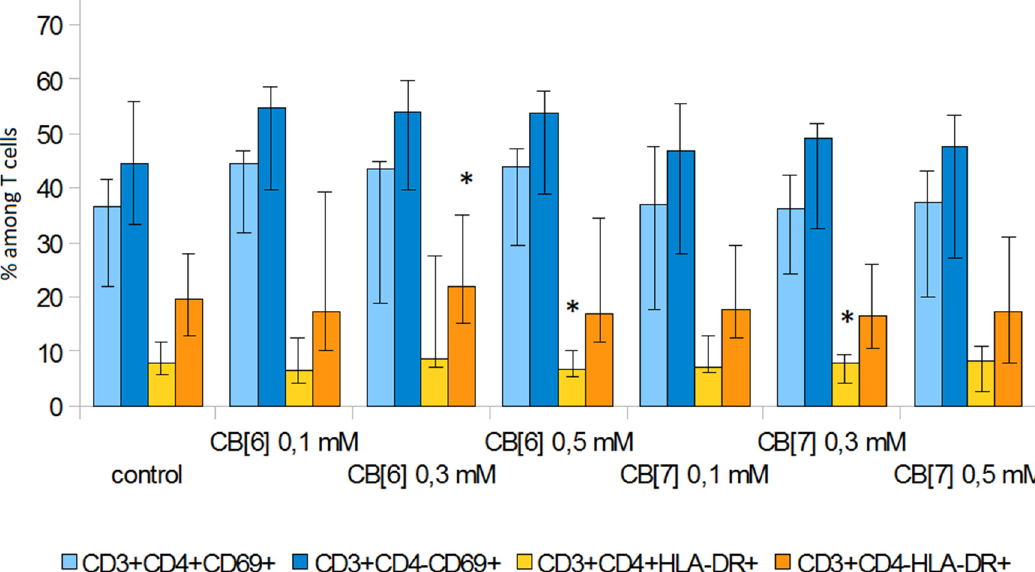
Figure 6. Effect of CB[n] on the expression of activation markers on T cells during anti ‐ CD3 ‐ induced proliferative activity of PBMCs. (* Indicates a significant difference ( p < 0.05) vs. the control).